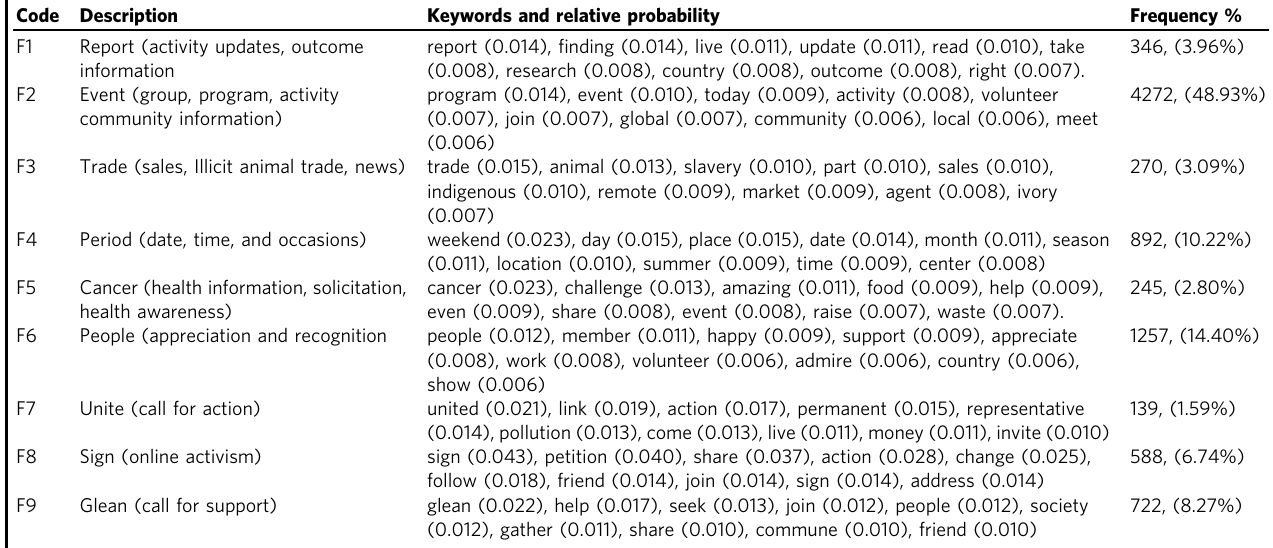
Table 5 Message functions, message frequencies, and keyword probabilities. Code Description Keywords and relative probability